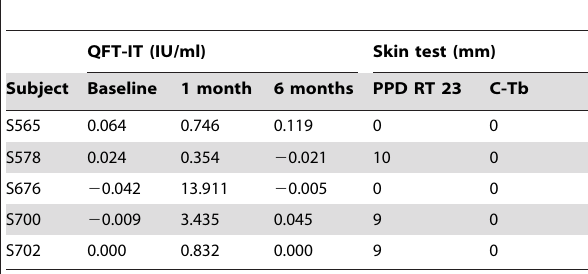
Table 2. IFN c among responders to C-Tb/PPD 1 and 6 months after skin testing in specificity